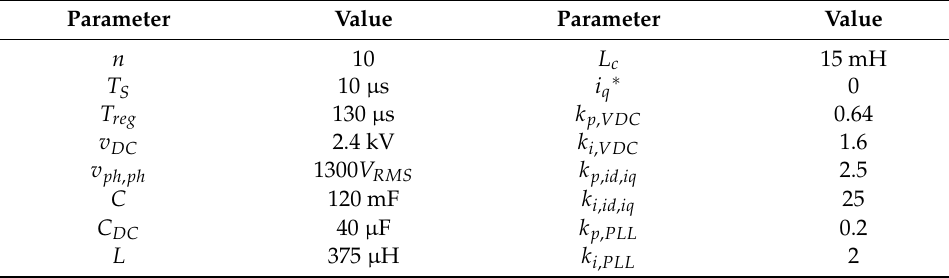
Table 4. Simulation parameters of the case under analysis.